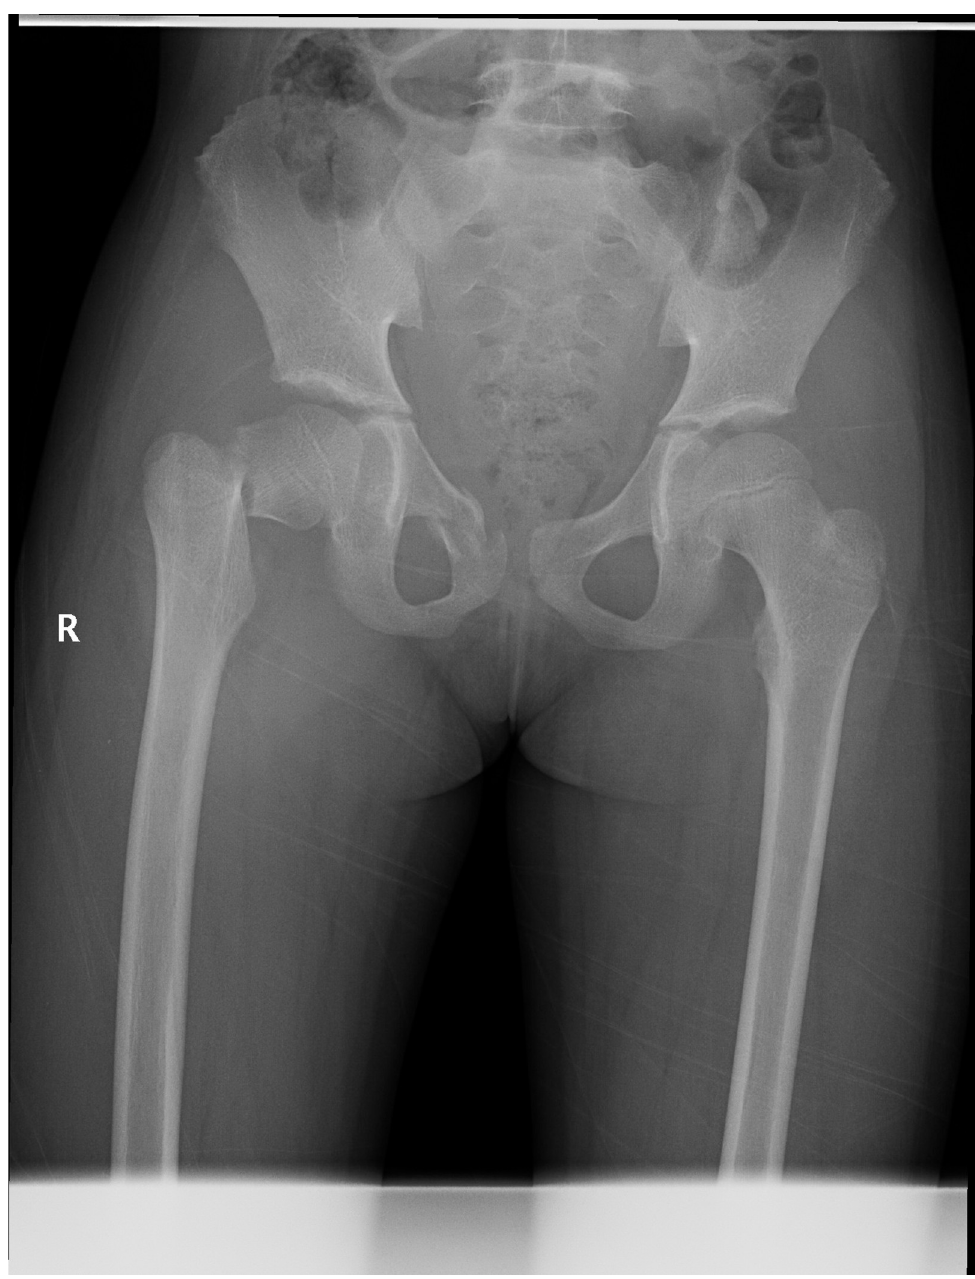
Fig 1. Fracture classification and displacement degree. Radiograph showing a Delbet type-III femoral neck fracture with significant